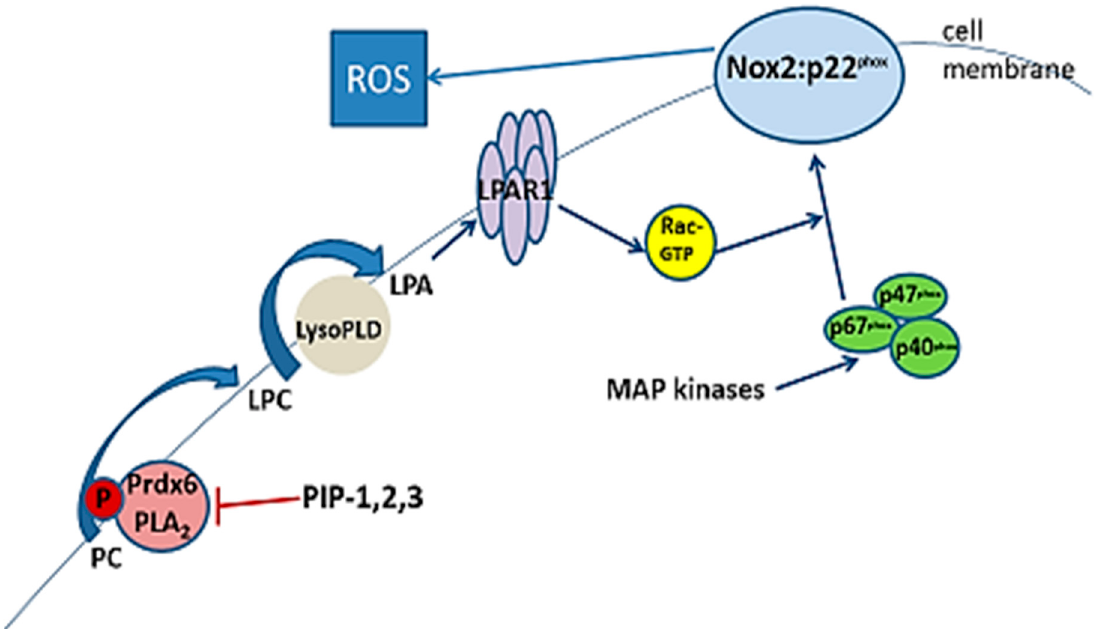
Figure 1. The pathway for activation of NADPH oxidase type 2 (Nox2). This pathway requires generation of lysophosphatidylcholine (LPC) through the PLA 2 activity of phosphorylated Prdx6; LPC is converted to lysophosphatidic acid (LPA) that binds to its cell membrane-localized receptor (LPAR1) leading to the activation of Rac (1 or 2). Activated Rac (Rac-GTP) binds to p67 phox and it along with other phosphorylated cytoplasmic factors (shown in green) bind to the membrane-localized Nox2 complex resulting in its activation to generate reactive oxygen species (ROS). The presence of one of the PLA2-inhibitory proteins (PIP-1, -2, or -3) inhibits PLA 2 activity and prevents Nox2 activation. PC, phosphatidylcholine; LysoPLD, lysophospholipase D; MAP kinase, mitogen activated protein kinase. Modified from [7] and reprinted with permission.